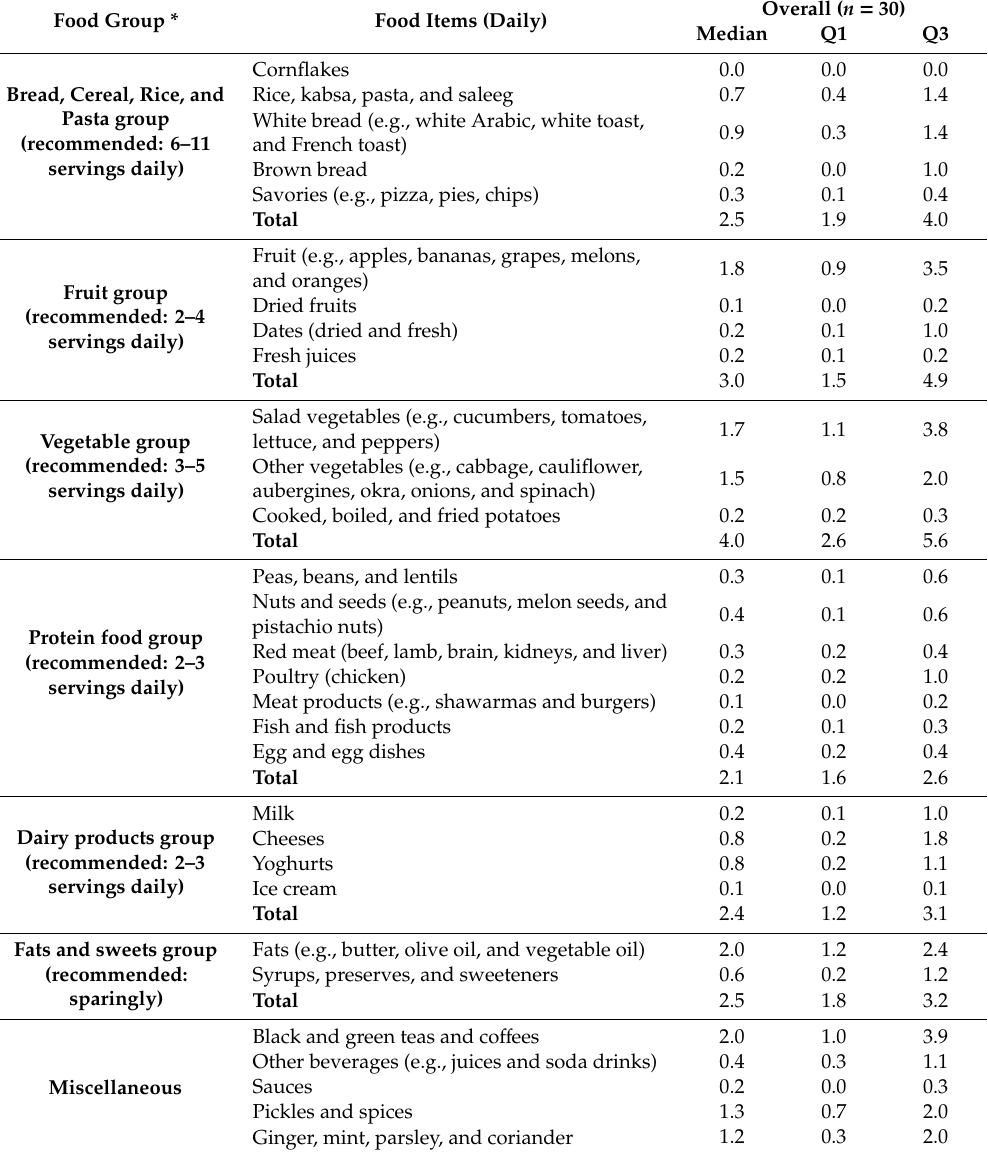
Table 3. Estimation of dietary intake (servings / day) in polypectomy patients based on the FFQ ( n = 30; male = 14, female =